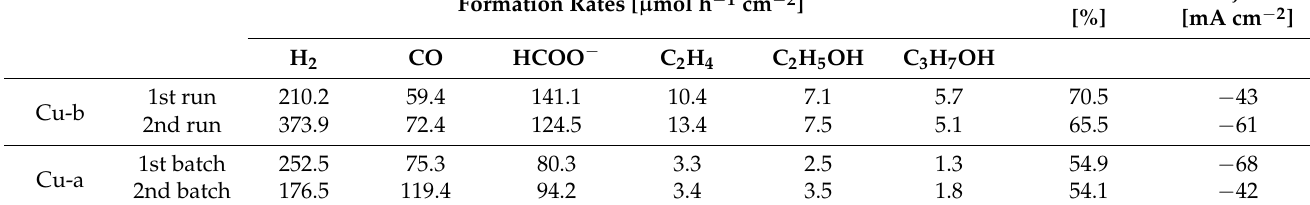
Table 4. Product formation rates, Faraday efficiency and current densities for two experiments using the same batch of copper catalyst Cu-b at E = − 1.7 V vs. Ag/AgCl in CO 2 -saturated 0.5 M KHCO 3 and for two different batches of copper catalyst